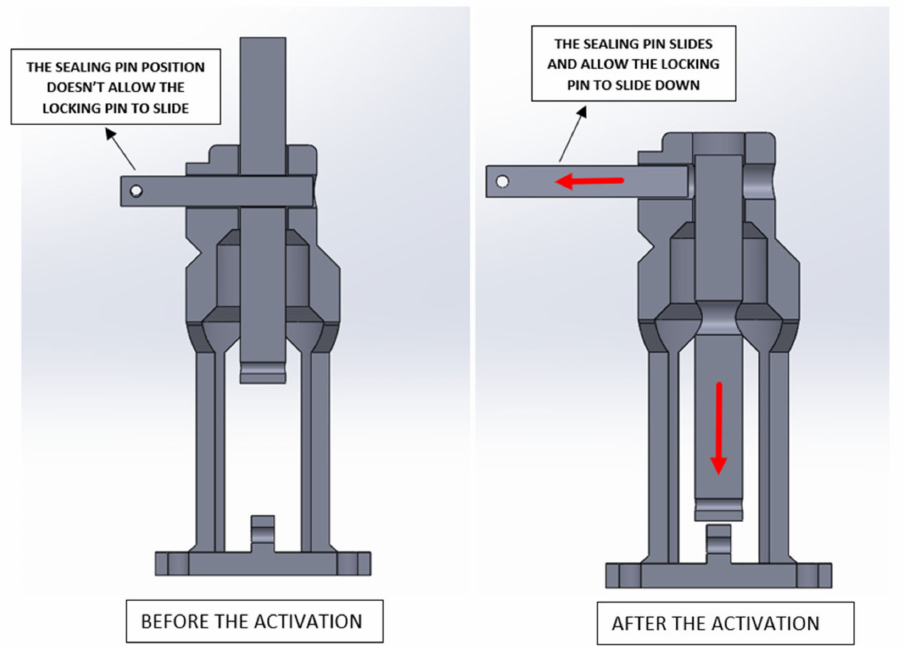
Figure 5. SMA actuator releasing scheme before and after the activation.